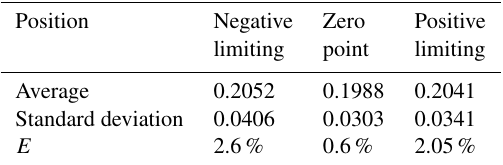
Table 2. Testing results around the Y axis (µrad).